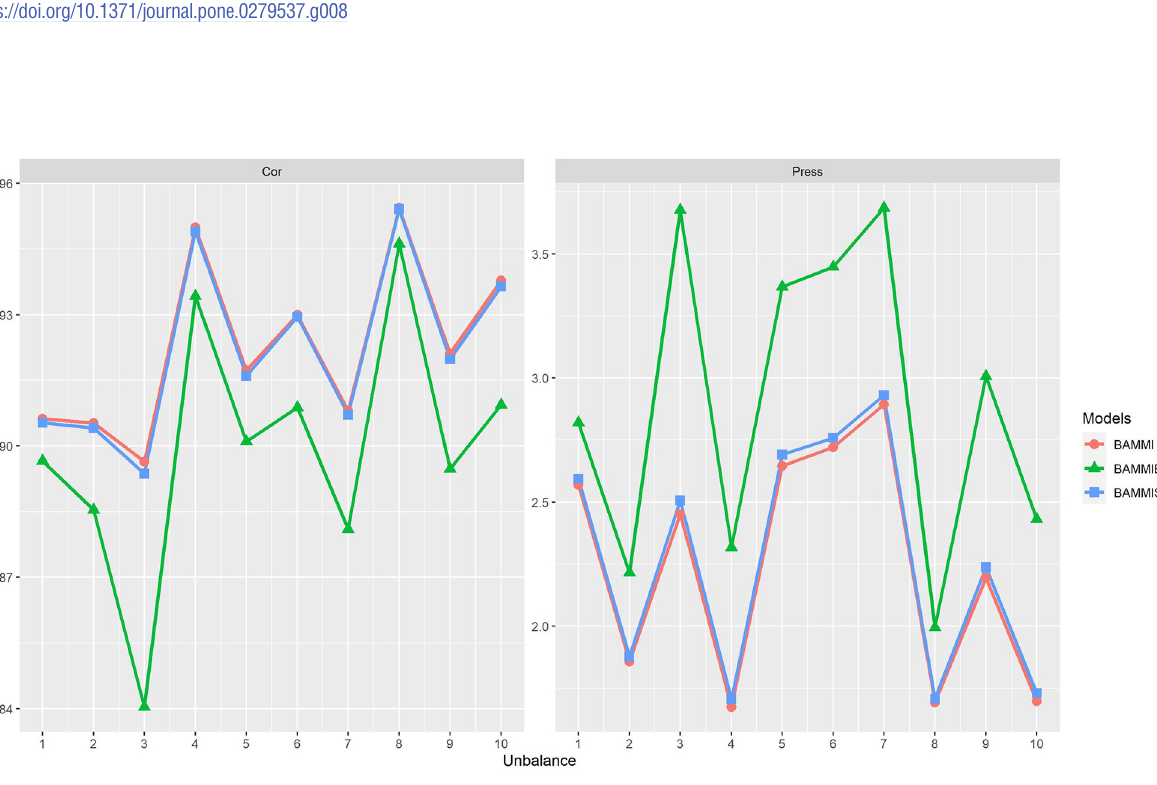
PLOS ONE | https://doi.org/10.1371/journal.pone.0279537 January 3,